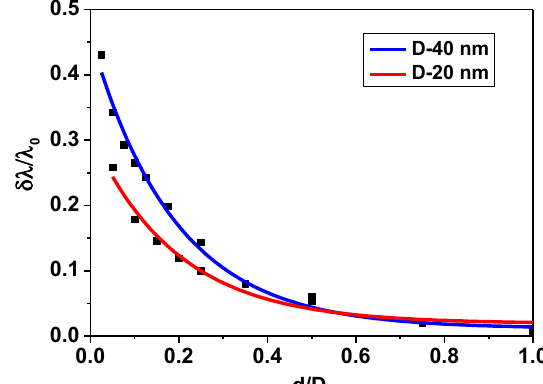
Figure 4: Fractional plasmon shift versus the ratio of spacing to the particle size for Al homo-dimer. The particle size is 20 nm and 40